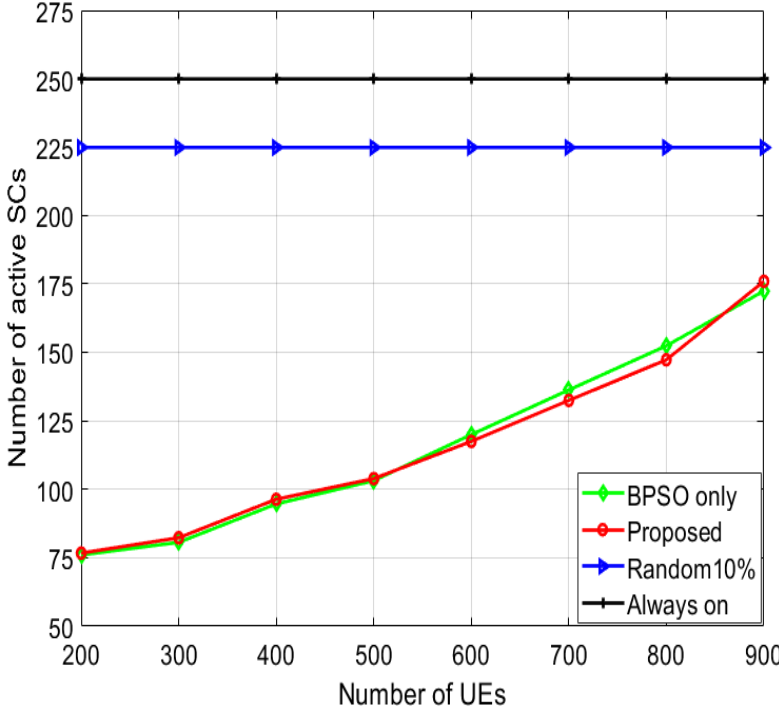
Figure 6. Number of active SCs for various numbers of UEs in case of linearly increasing IW.